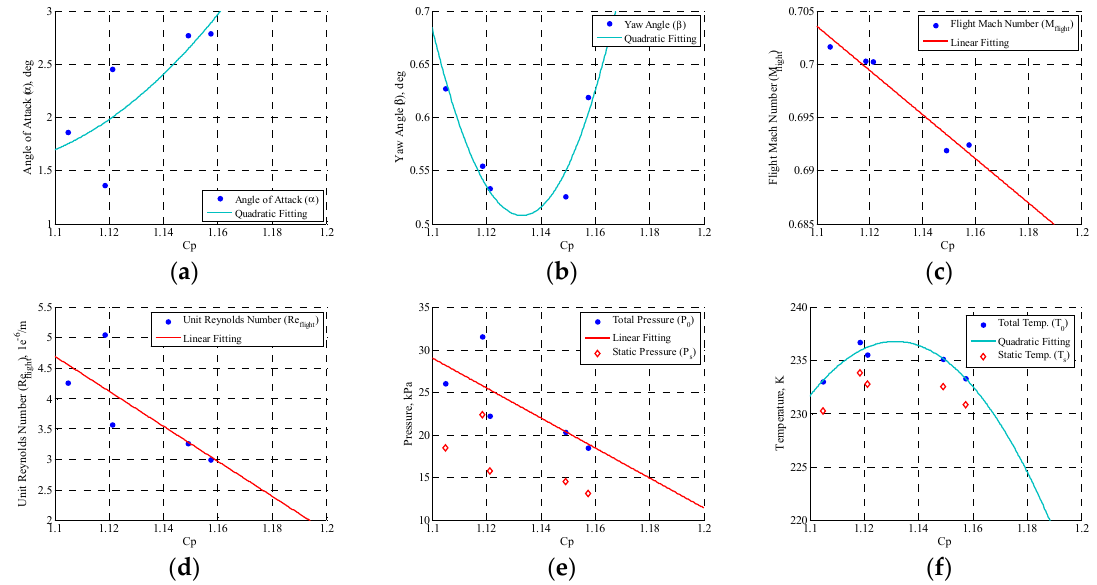
Figure 6. Sensitivities of each variable on C p (at outmost probe height): ( a ) angle of attack; ( b ) yaw angle; ( c ) flight Mach number; ( d ) unit Reynolds number; ( e ) total and static pressures; ( f ) total and static temperatures.